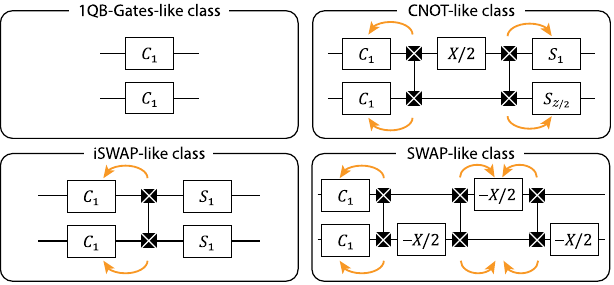
FIG. 27. Two-qubit Clifford classes written in terms of the iSWAP gate and single-qubit gates. Since our native iSWAP gate accompanies additional unwanted single-qubit Z rotations, we incorporate compensating Z rotations into the existing single- qubit gates that are either preceded or followed by the iSWAP gate to undo the unwanted Z rotations. The orange arrows denote which single-qubit gates are subject to be updated to undo the Z rotations of the iSWAP.